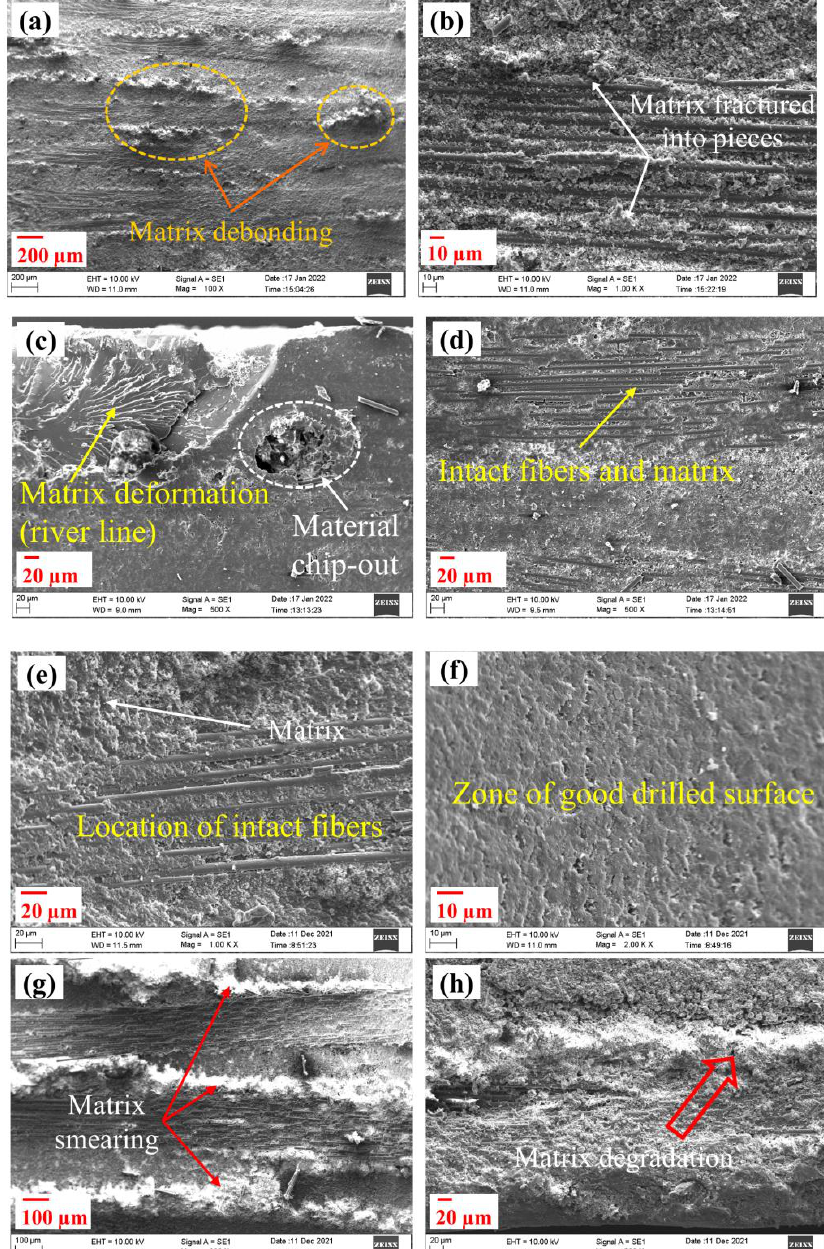
Figure 9. Morphology of MoS 2 -loaded CEC drilled at ( a , b ) A = 1000 rpm, B = 0.07 mm.rev −1 , C = 4 mm, D = 4 wt%; ( c , d ) A = 3250 rpm, B = 0.05 mm.rev −1 , C = 4 mm, D = 6 wt%; ( e , f ) A = 3250 rpm, B = 0.05 mm.rev −1 , C = 6 mm, D = 6 wt%; ( g , h ) A = 3250 rpm, B = 0.05 mm.rev −1 , C = 6 mm, D = 8 wt% and ( i , j ) A = 5500 rpm, B = 0.07 mm.rev −1 , C = 8 mm, D = 8 wt%.